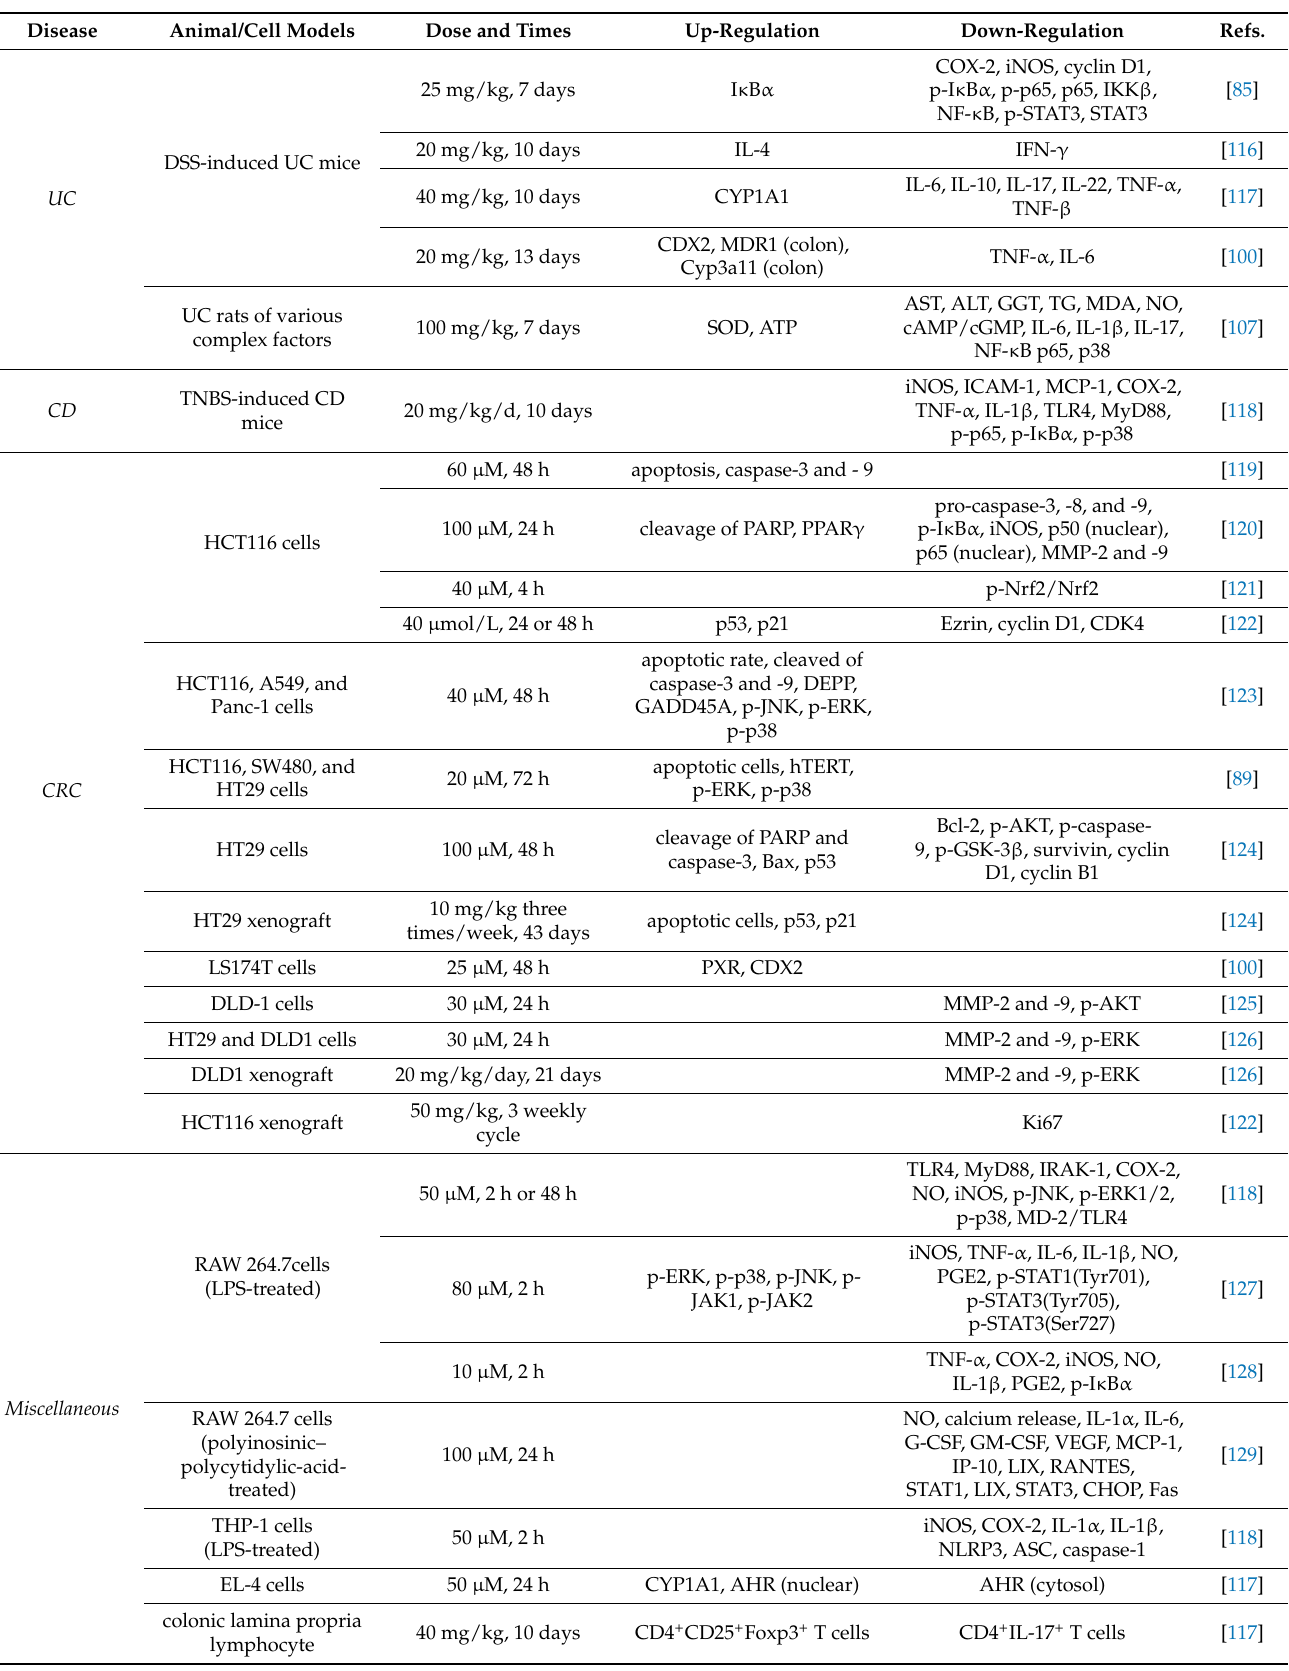
Table 2. The effect of baicalein on inflammatory bowel disease and colorectal